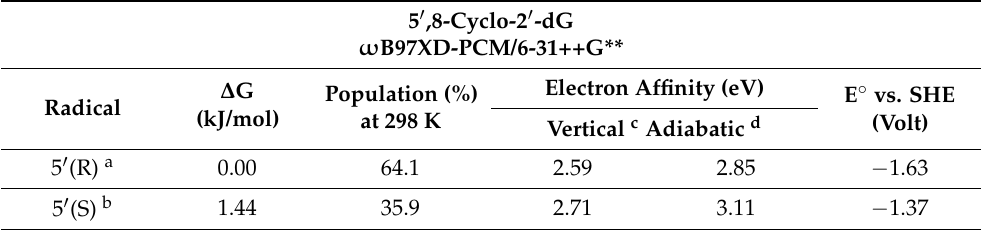
Table 4. The ω B97XD-PCM/6-31++G**-calculated relative free energies ( ∆ G), relative